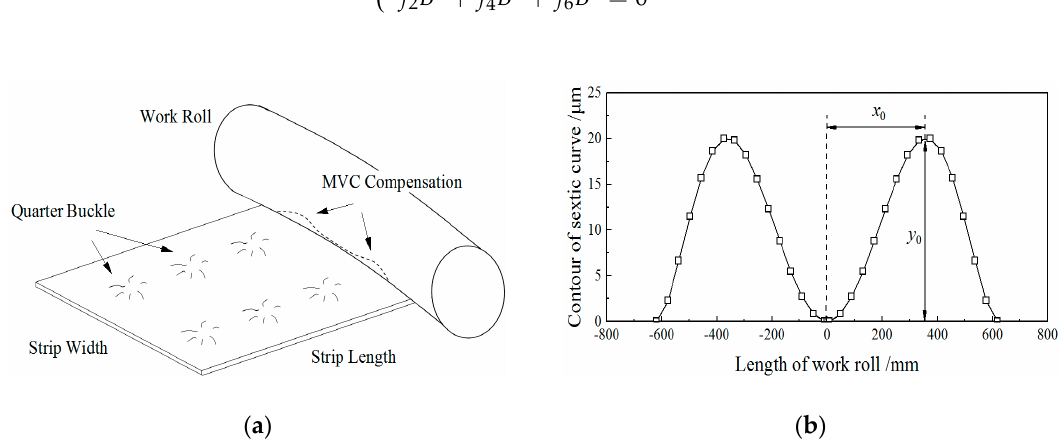
Figure 22. Compensation for the quarter buckle by the MVC: ( a ) schematic diagram; ( b ) contour of the sextic curve.